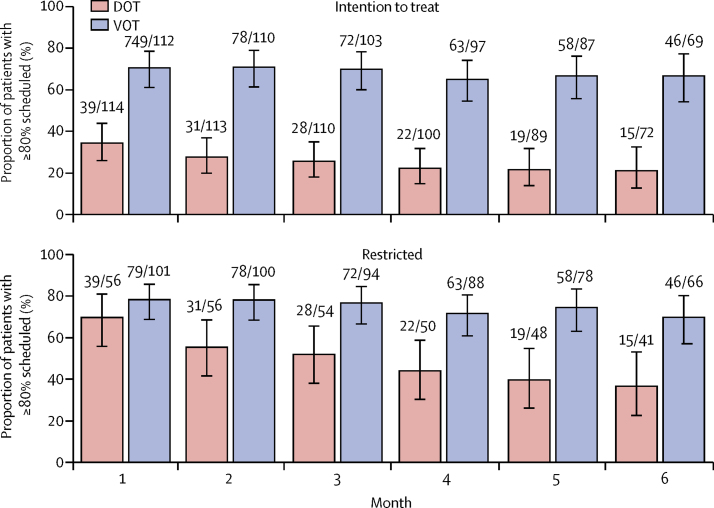
Proportions of patients with 80% or more of scheduled doses observed through treatmentNumbers above bars are the numbers of patients who had scheduled treatment observations in each month following randomisation and the numbers who completed 80% or more scheduled observations. Error bars are 95% CIs.